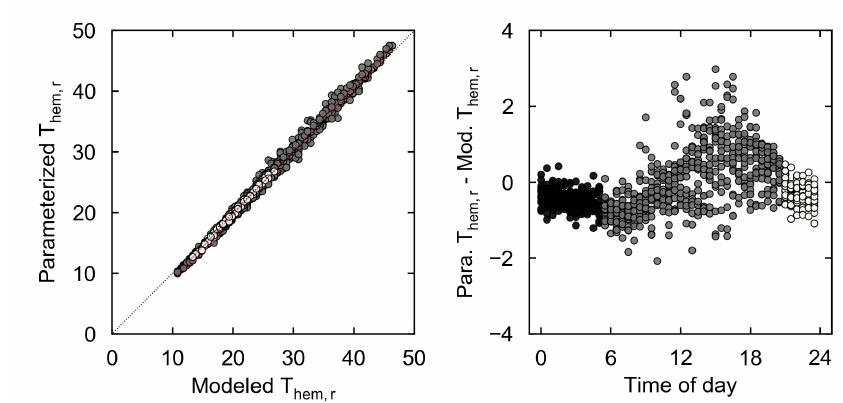
Figure 6. Modeled T hem, r versus T hem, r derived via the parameterization scheme. Shading indicates time of day (black is midnight through 5:00 a.m. local standard time, grey is 5:30 a.m. through 8:00 p.m. LST, white is 8:30 p.m. through 11:30 p.m.